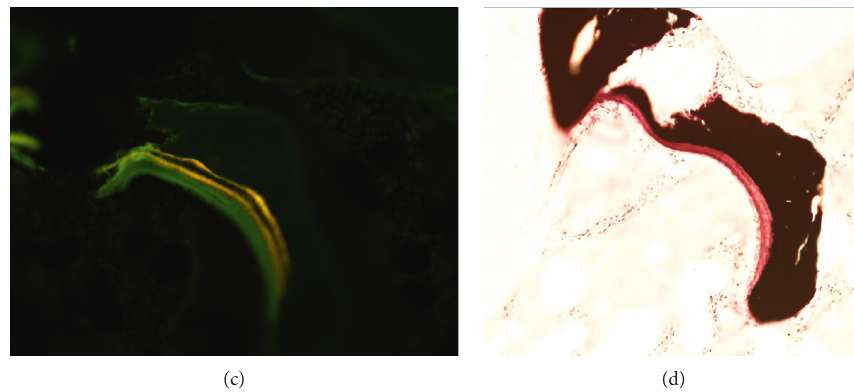
Figure 2: Bone biopsy. (a) High resolution (alkaline phosphatase staining). (b) Low resolution (alkaline phosphatase staining). Both low and high power showed irregularity, variability, and loss of connectivity of bone trabeculae, with some thinning and scattered bone nubbins. (c) Unstained bone biopsy. (d) The Von Kossa (calcium) stain showed the thickened osteoid seam (red) with the calcified bone